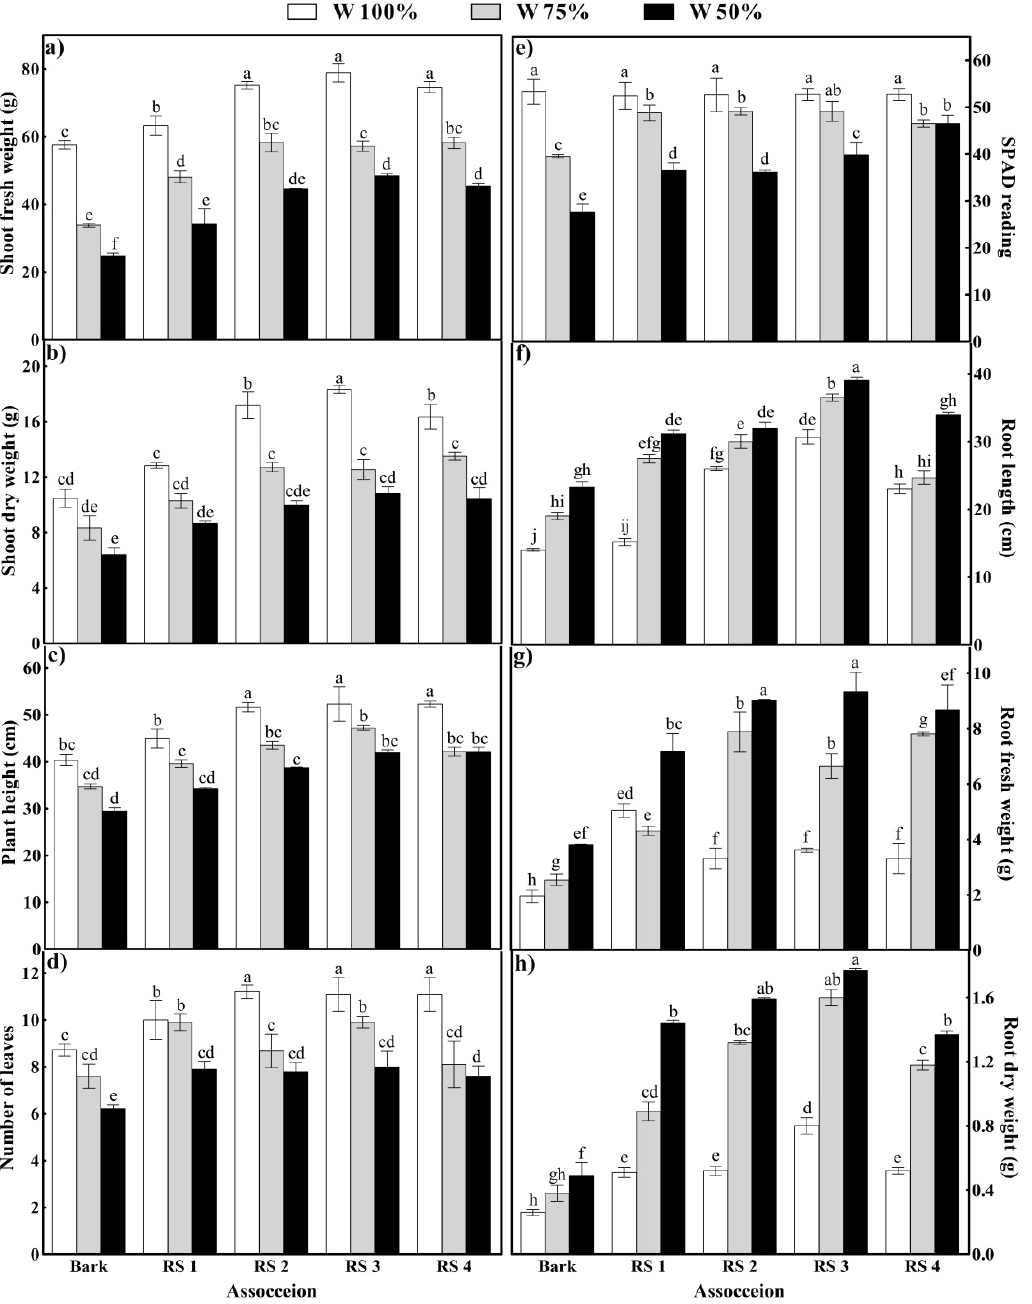
Figure 2. Effect of interaction between drought treatments and rootstock on ( a ) shoot fresh weight, ( b ) shoot dry weight, ( c ) plant height, ( d ) number of leaves, ( e ) SPAD reading, ( f ) root length, ( g ) root fresh weight, and ( h ) root dry weight. Different letters indicate significant differences between treatments (Tukey test at p <